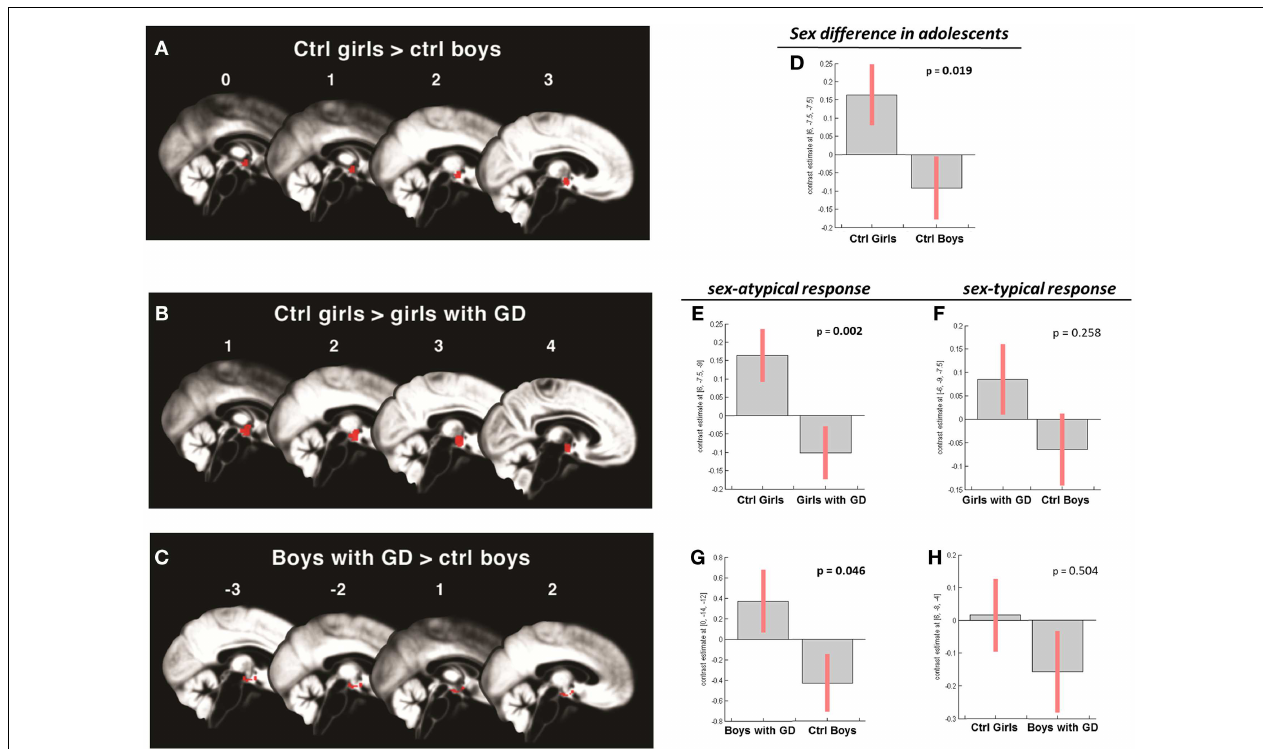
contrasts of the first-order time-modulation regressor, indicating sensitization to the steroid odor in control girls compared with (A) control boys and (E) girls with gender dysphoria. (F) Shows the non-significant sex-typical (female-like) response of girls with gender dysphoria. (G) Displays the significant female-typical response of the boys with gender dysphoria for the contrast of the condition ON > OFF, irrespective of any effects of time; (H) shows the non-significant male-typical response of boys with gender